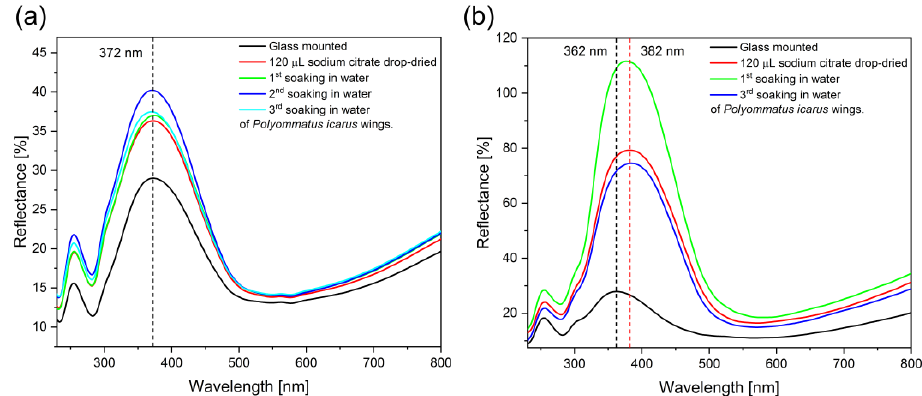
Figure 10. Spectral “history” of sample ‘drop-dried sodium citrate’ from Figure 9 after the application of 120 µL of sodium citrate solution and after several steps of soaking for 8 h in deionized water. Each soaking step was followed by overnight drying before re-measuring the sample. Spectra were recorded with the integrating sphere and at normal incidence for panels ( a ) and ( b ), respectively.